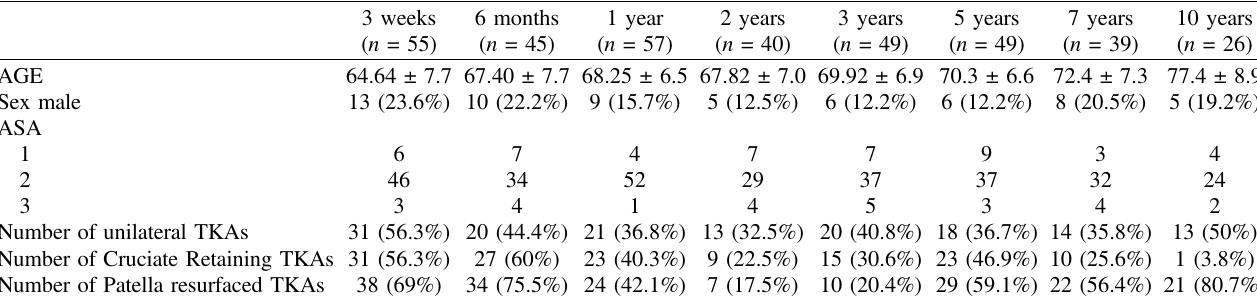
Table 1. Patient